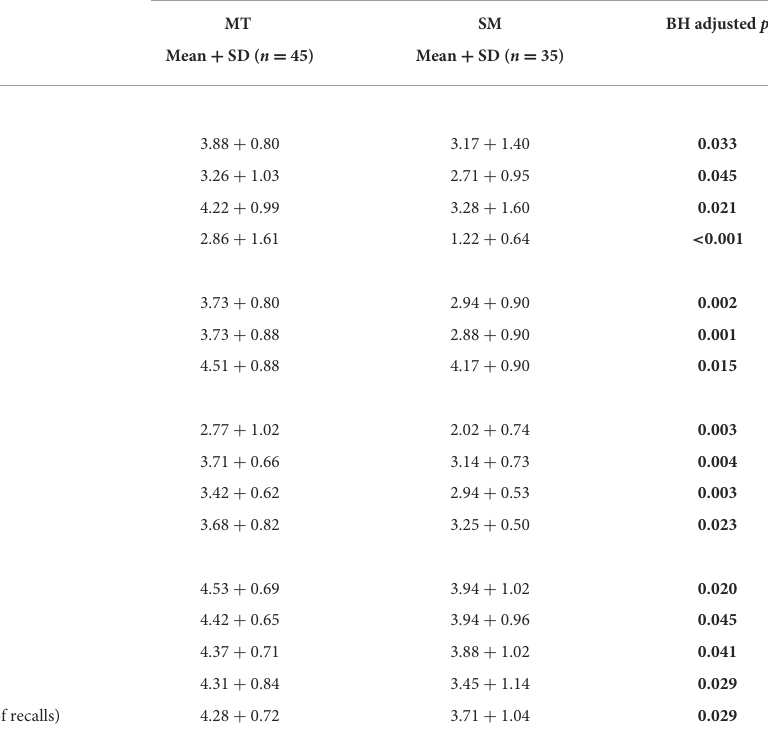
TABLE 3 Statistically significant ( p < 0.05) differences between mean responses of recruitment sources MTurk (MT) and social media (SM) responses following adjustment using the Benjamini-Hochberg